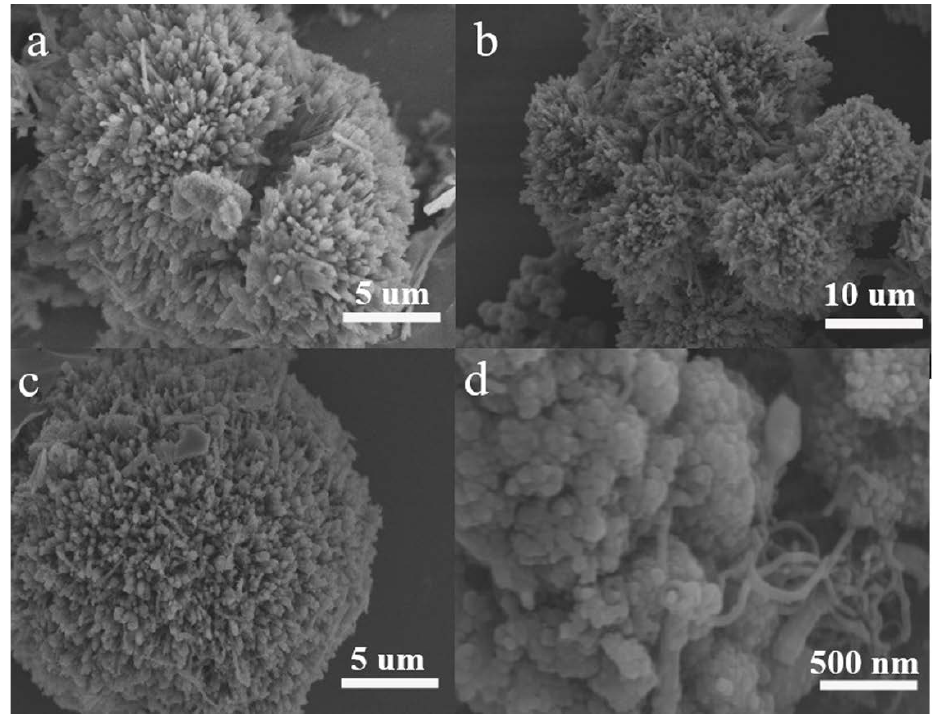
Figure 3. Scanning electron microscopy (SEM) images of ( a ) NiZn metal-organic framework (MOF) precursor without CNT; ( b , c ) 0% CNT; ( d ) 5% CNT.